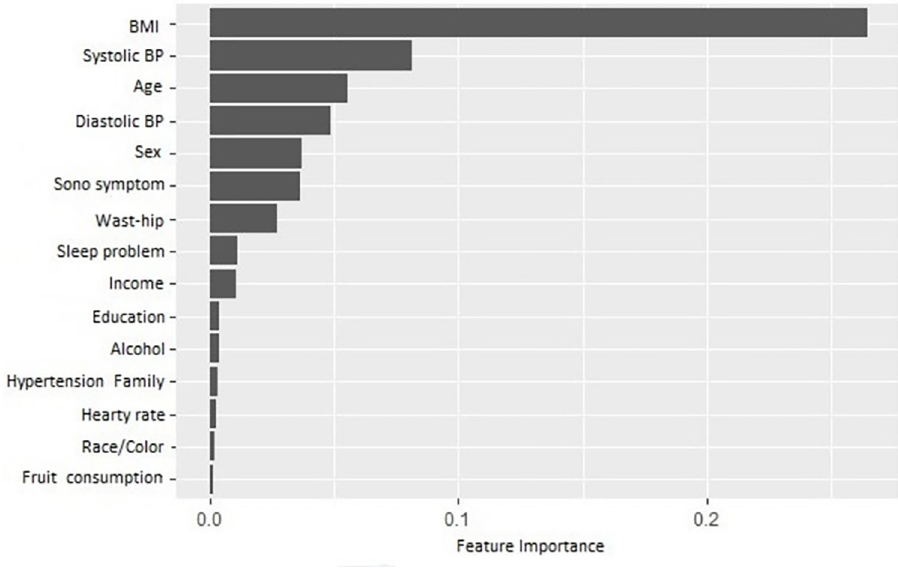
Fig 3. Average variable importance for the first top 15 features using multivariate random forest. BP-Blood Pressure; BMI-Body Mass Index.